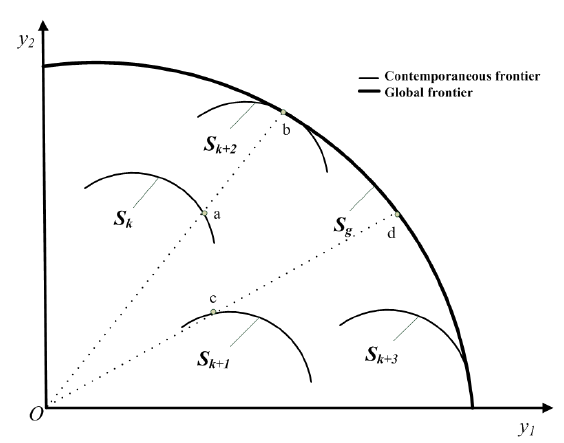
Figure 3. Graphical illustration of the global Malmquist index (MI).